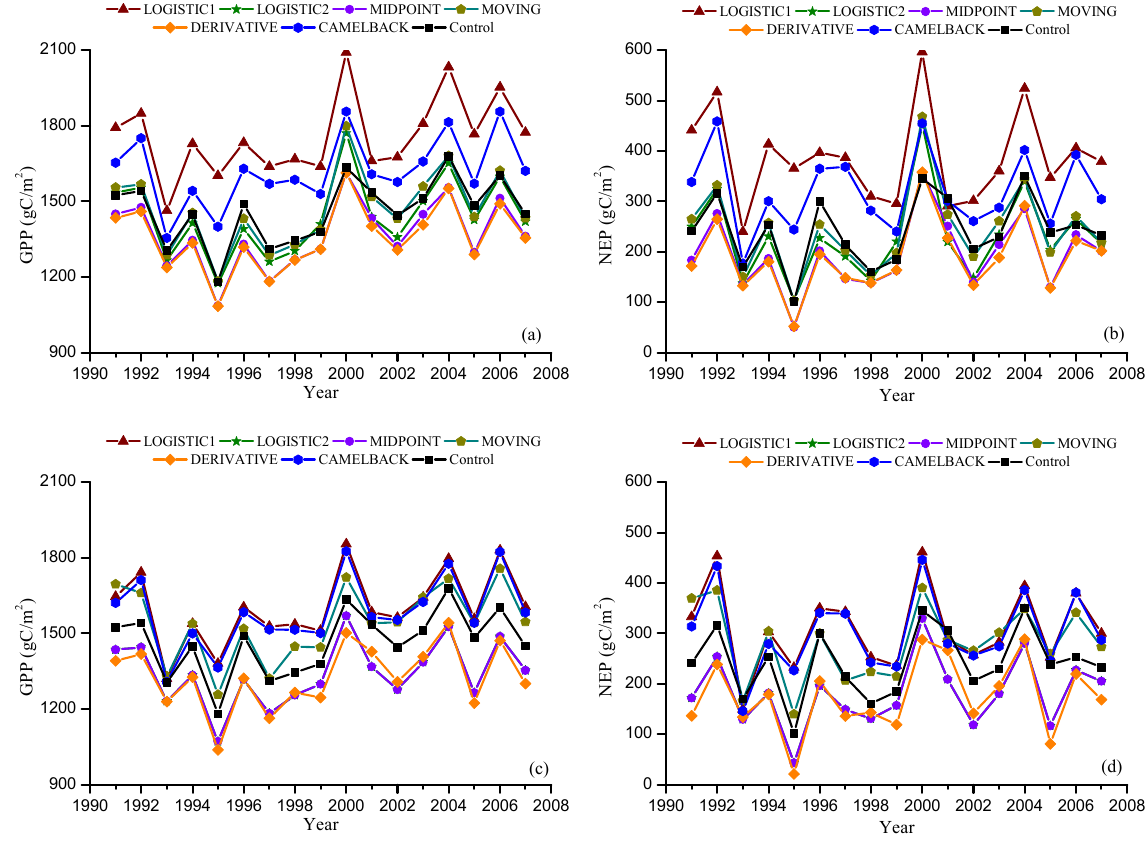
Figure 5. Simulated annual Gross Primary Productivity (GPP) and Net Ecosystem Production (NEP) from Dynamic Onset experiment. Leaf onset dates were simulated using the “Sequential” model with the parameters optimized against remotely sensed onset using NDVI ( a , b ), and EVI ( c , d ).